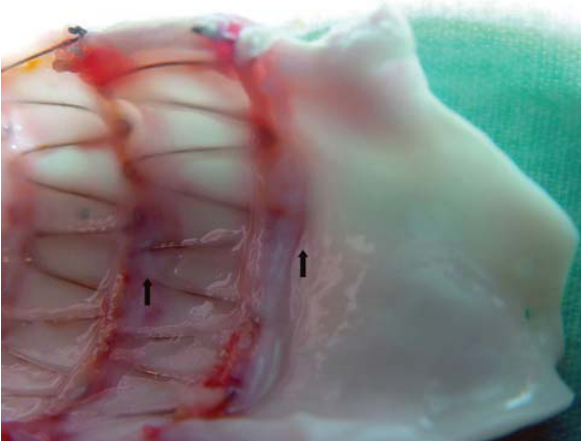
Fig. 1 - Corte longitudinal da aorta, no qual visibilizamos a transição entre a parede aórtica normal e a região espessada pelas reações induzidas pelo